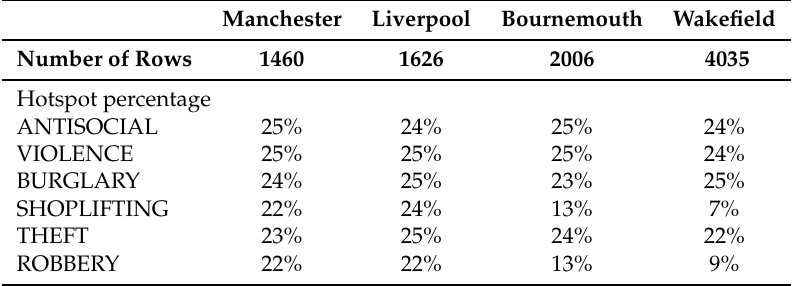
Table 2. Data size and hotspot